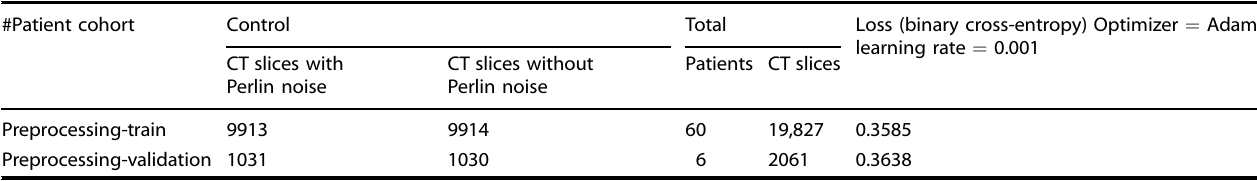
Table 1. Detail information of the samples in multiple steps of analysis (preprocessing, train, validation, and test phases). #Patient cohort